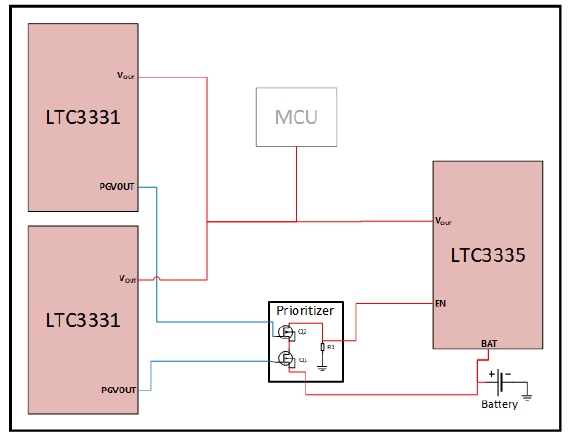
Figure 5. Priority is given to harvested energy and rechargeable over non-rechargeable batteries utilizing the PGVOUT signal of each LTC3331.